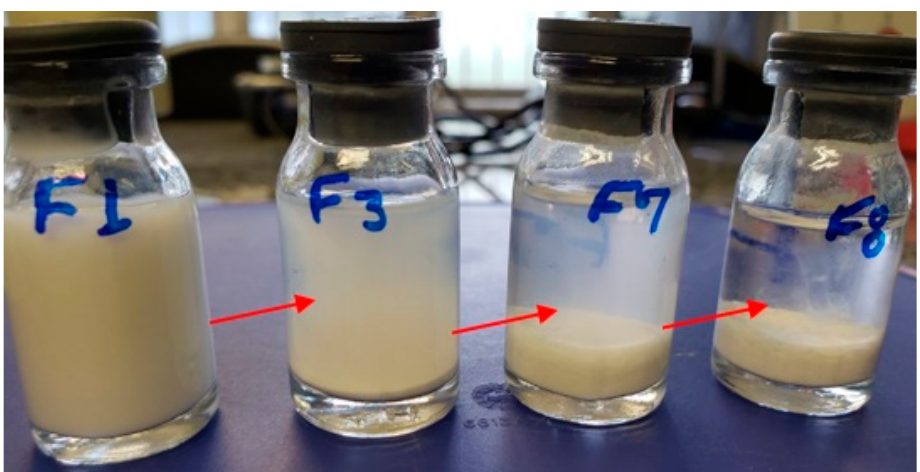
Figure 2. Aspect of the formulas containing the stabilizers Povacoat ® 1.0 wt% (F1), Kollicoat ® 0.3 wt% + Chitosan 0.3 wt% (F3), Poloxamer ® 407 0.5 wt% + Chitosan 0.5 wt% (F7), and Poloxamer ® 407 0.3 wt% + Chitosan 0.3 wt% (F8). Stability after 15 days (25 °C).